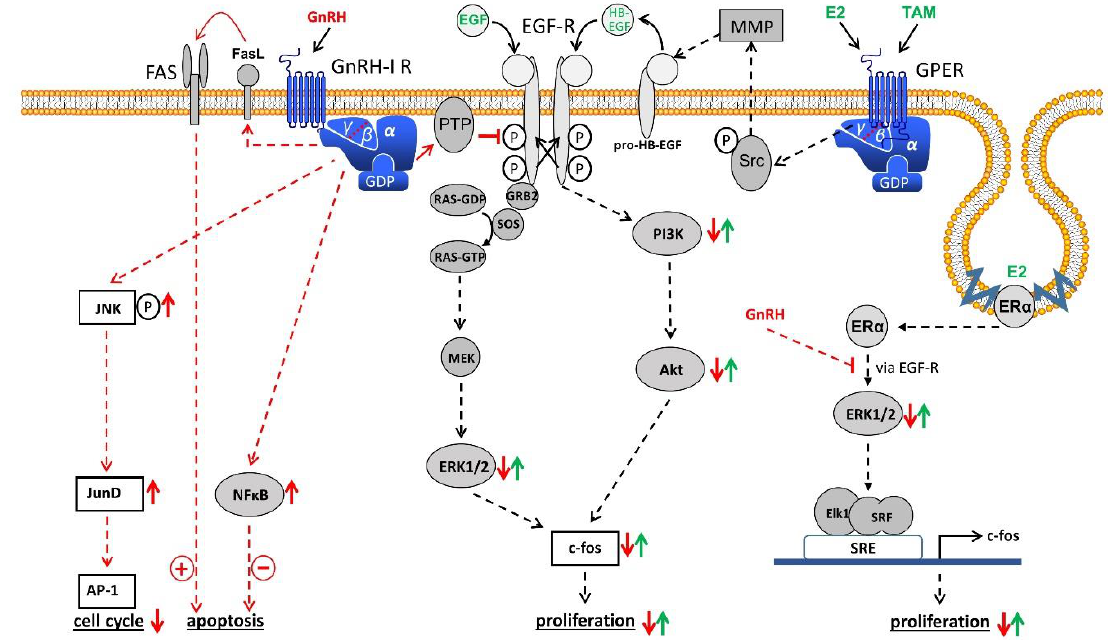
Figure 1. Gonadotropin releasing hormone (GnRH) receptor signal transduction in endometrial cancer (EC). Binding of GnRH-I and GnRH-I agonists causes G-protein αi-mediated activation of phospho-tyrosine phosphatase (PTP), resulting in dephosphorylated EGF-receptor (EGF-R) and inhibition of EGF-R signal transduction through the ERK1/2 or the PI3K/AKT pathway leading to a reduction of proliferation. GnRH-induced activation of PTP also inhibits the signaling cascade of G-protein coupled estrogen receptor (GPER) and estrogen receptor α (ERα) through transactivation of EGF-R. In addition, GnRH induces activation of NFκB to reduce and FAS-ligand to increase apoptosis. Finally, GnRH agonists activate the JNK/AP-1 pathway, resulting in an increased G0/1 phase of the cell cycle and decreased DNA-synthesis. Akt, protein kinase B (PKB). AP-1, activator protein-1. E2, estradiol. EGF, epidermal growth factor. ERK1/2, p44/42 mitogen-activated protein (MAP) kinase. FAS, Fas receptor. FasL, Fas ligand. GDP, guanosindiphosphate. GRB2, growth factor receptor-bound protein 2. GTP, guanosintriphosphate. HB-EGF, heparin-binding EGF-like growth factor. JNK, c-Jun N-terminale kinase. JunD, transcription factor JunD. MEK, mitogen-activated protein kinase kinase (MAP2K). MMP, matrix metalloproteinase . NFkB, nucleus factor kB. PI3K, phosphoinositide 3-kinase. RAS, G-protein rat sarcoma. SOS, guanine nucleotide exchange factor ”son of sevenless“. SRE, serum response element. Src, tyrosine kinase cellular sarcoma. SRF, serum response factor. TAM, tamoxifen.